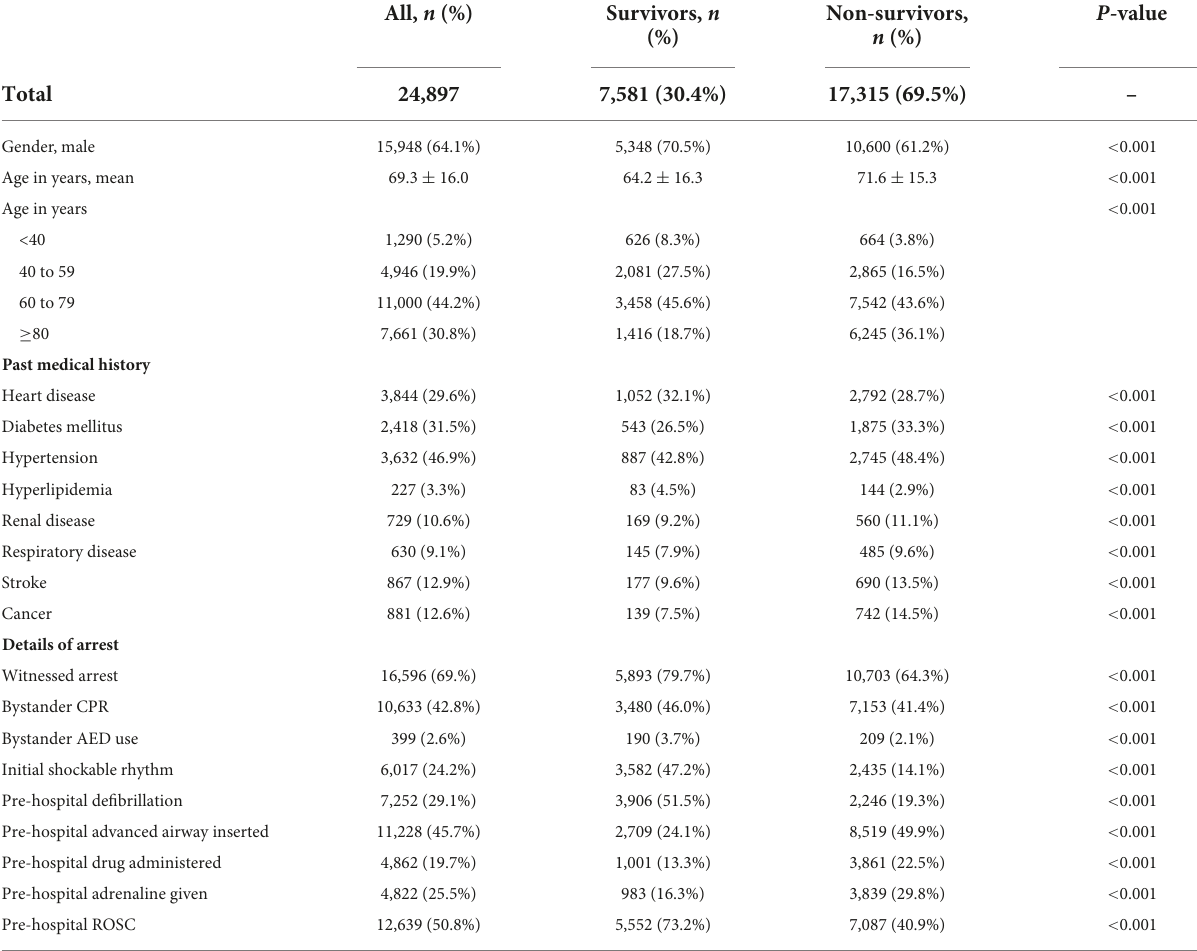
TABLE 1 Clinical characteristics of the study cohort, with comparison between survivors and non-survivors.